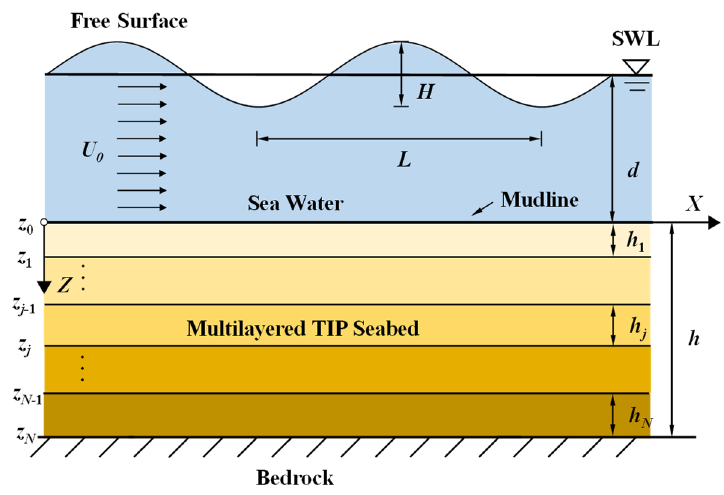
Figure 1. Sketch of a multilayered TIP seabed under a wave-current interaction.